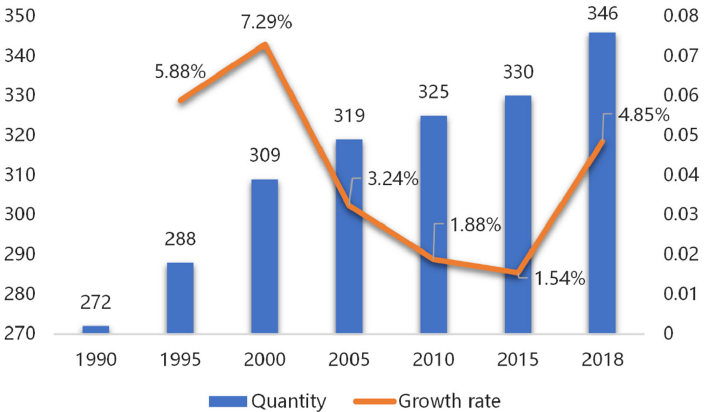
Figure 10. Incorporation of world cultural heritage sites into urban areas from 1990–2018.